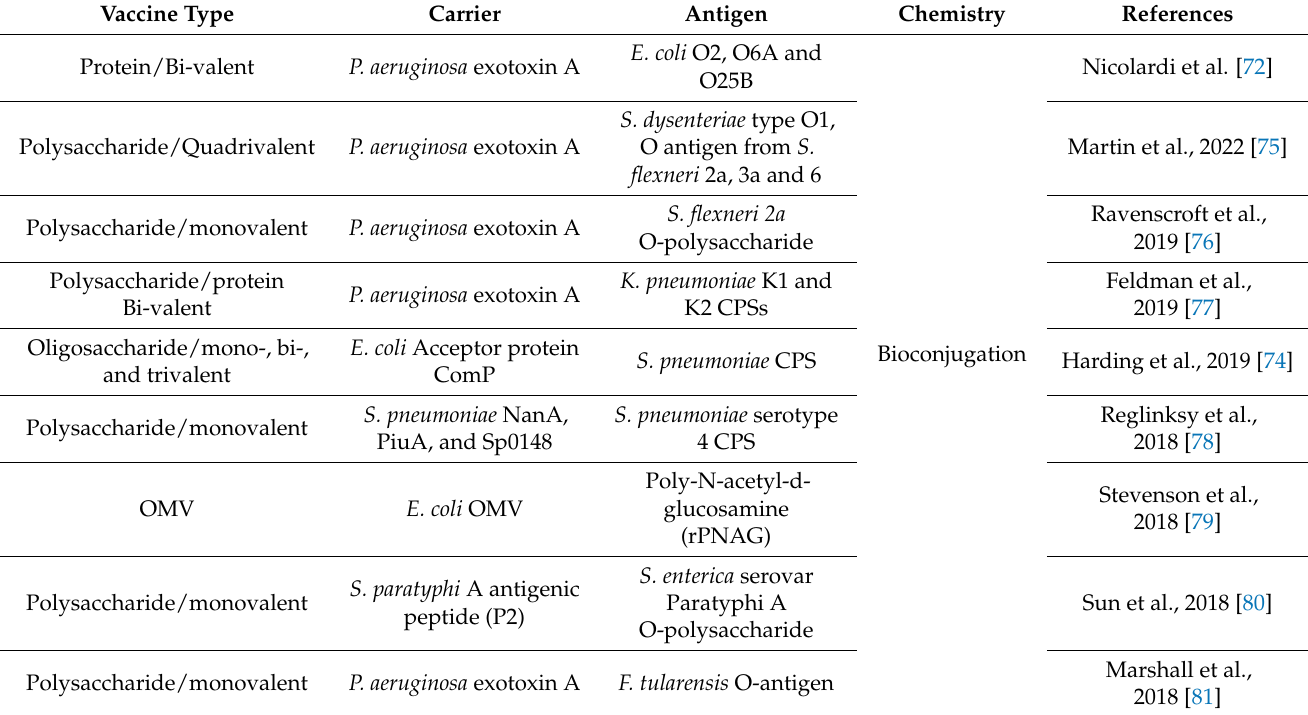
Table 2. Glycoengineered conjugation strategies.